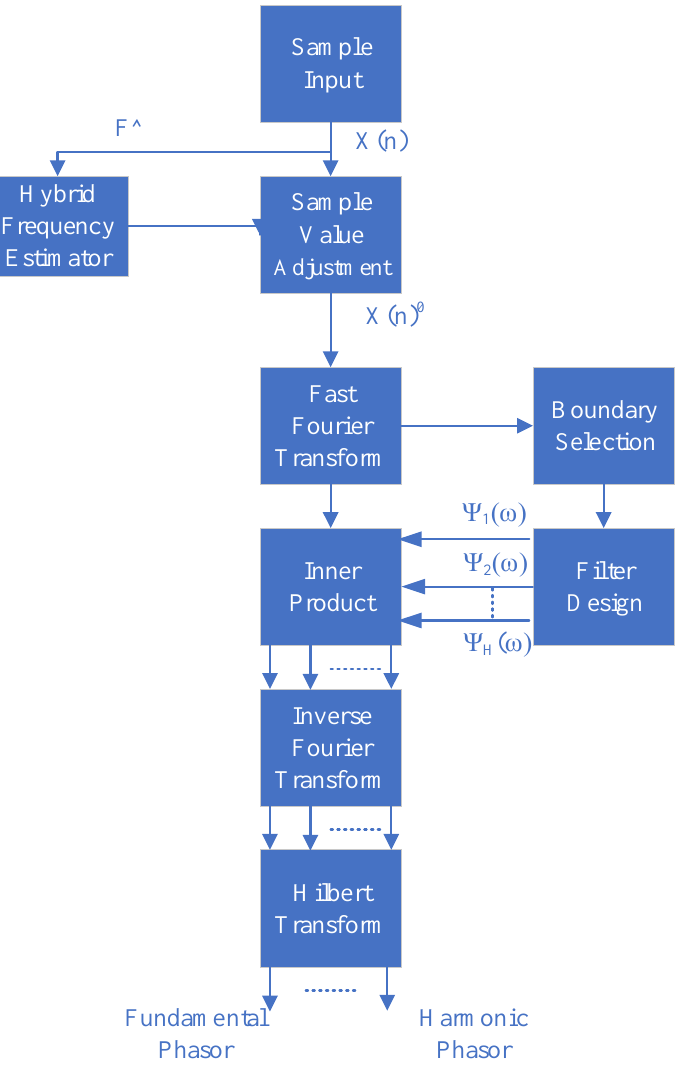
Figure 2. Example of empirical wavelet transform empirical wavelet transform-based D-PMU. The sampled input is passed through the frequency estimator. Since, in most cases, it is off the nominal frequency in the distribution network, it is passed through a